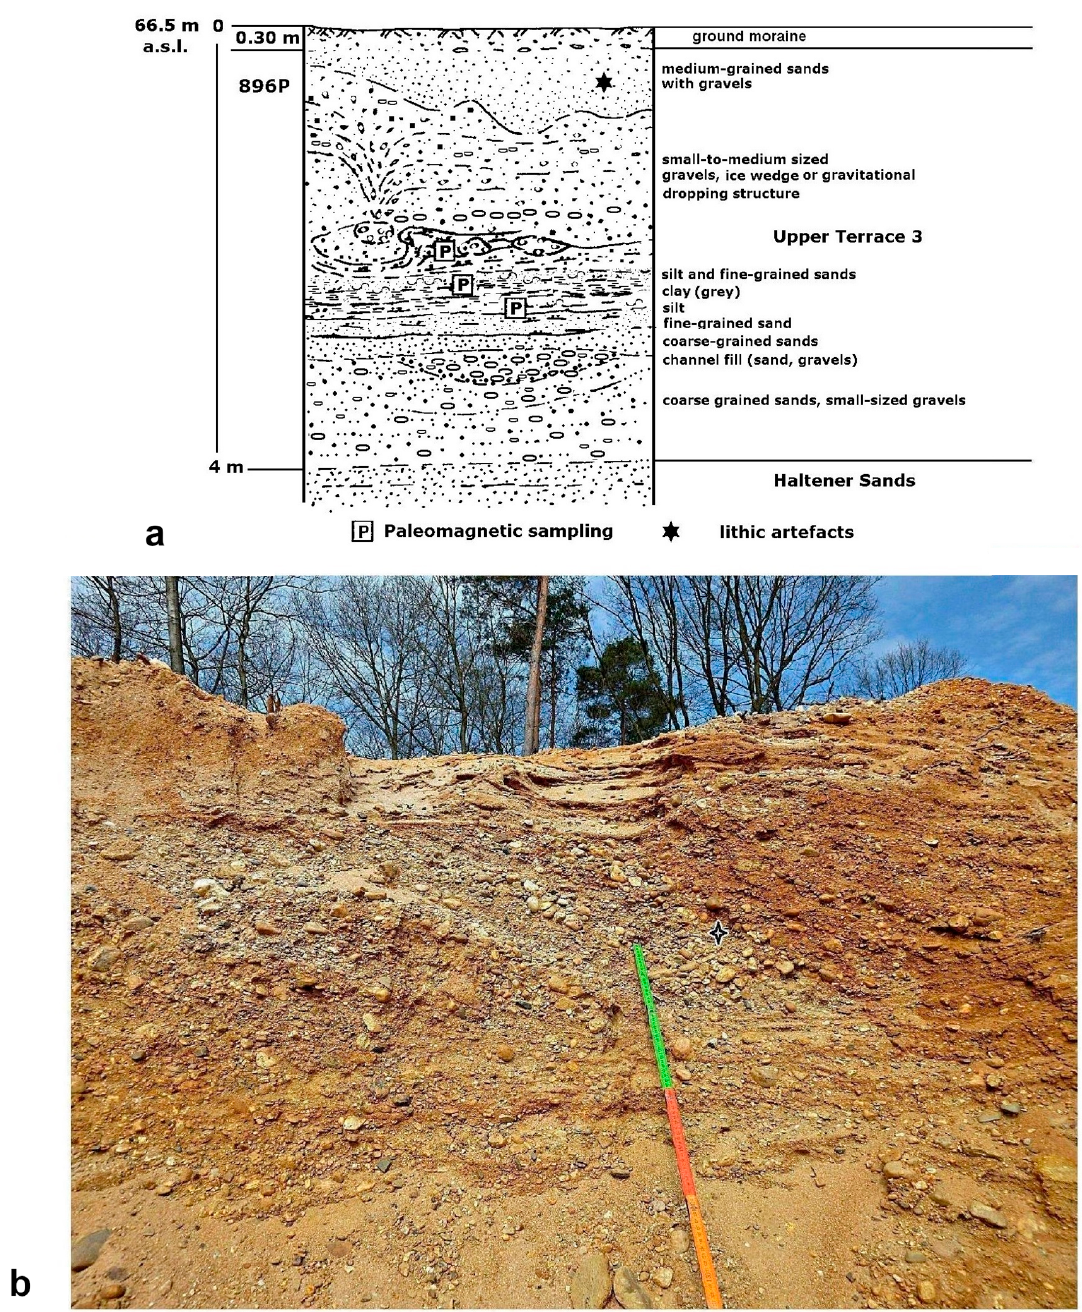
Figure 22. Dorsten-Schermbeck. ( a ) Terrace profile (outlined by G. Landeck); ( b ) the upper part of the terrace (Photo: H. Klingelhöfer.).